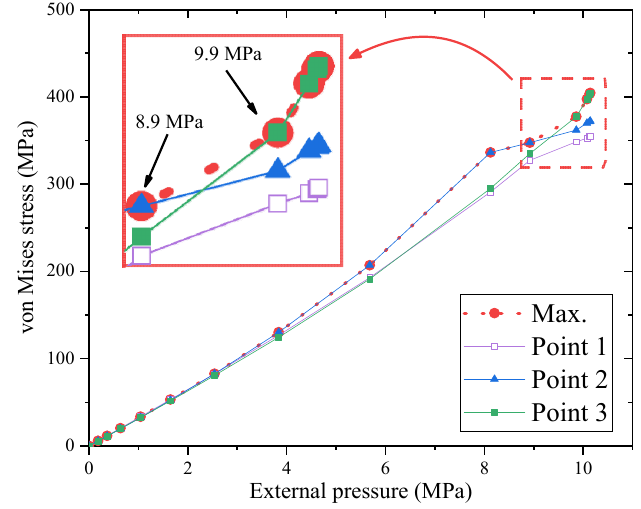
Figure 20. Stress curves of three points in the pipeline.